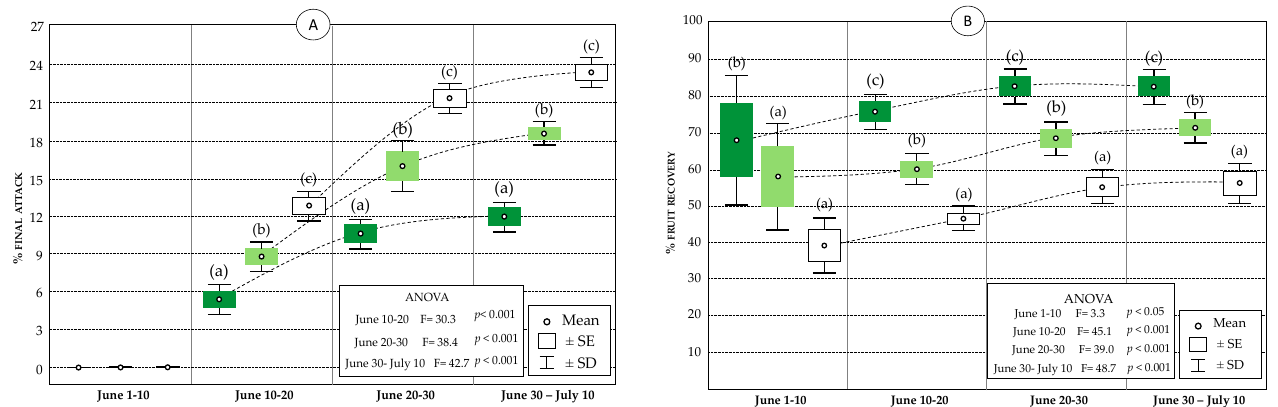
Figure 8. Statistics (mean, standard error, and standard deviation) of the final attack of P. oleae eggs in the olive groves subject to different management ( A ), and of fruit recovery ( B ) in VC-MIX (dark green), VC (light green), and conventional (white). Significant differences within each sampling are indicated by letters (Tukey’s HSD test, p < 0.05).